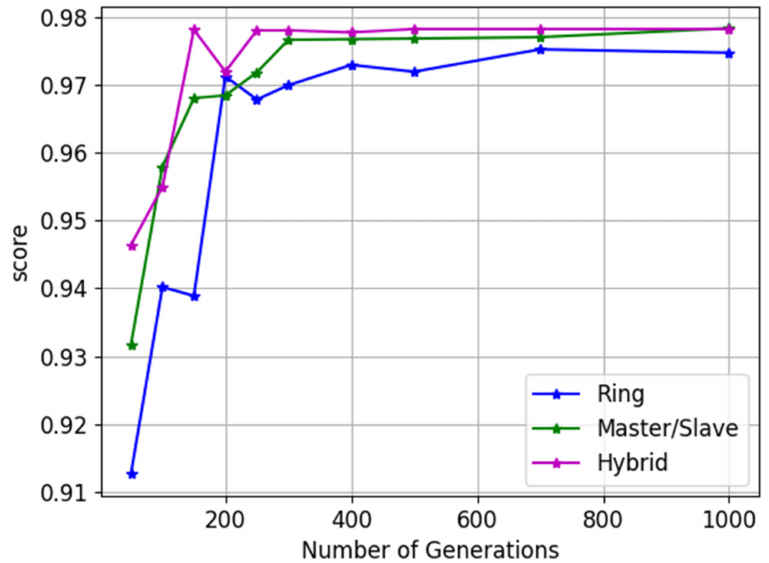
Figure 12. Scores of different strategy agents (Ring, Master/Slave, and